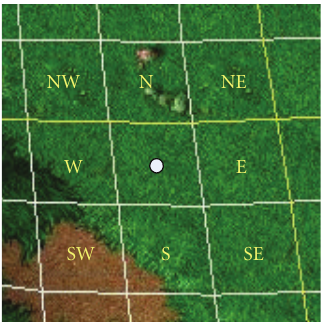
Figure 7: Representation of the first 8 neighbor cells.